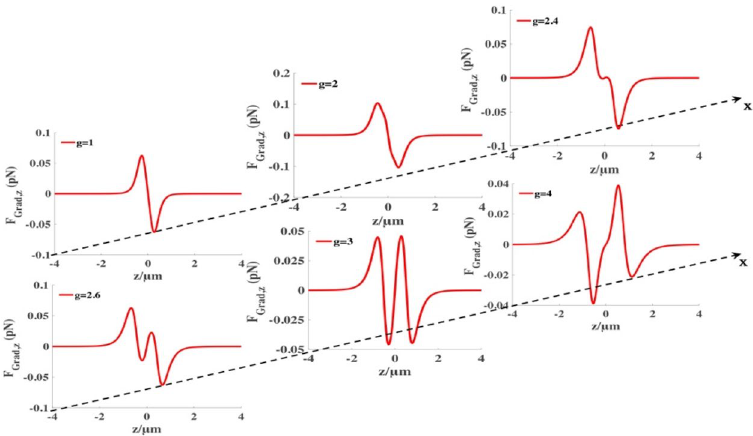
n p = 1.592 Rayleigh (cid:31) (cid:30)